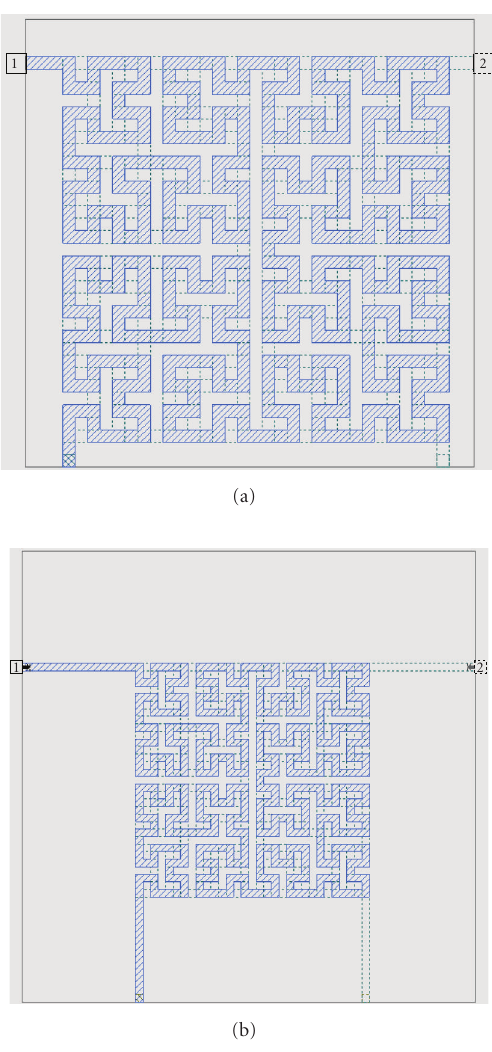
Figure 8: A top view of fractal transformers realized with two Hilbert curves N = 4, (a) w p = w s = 10 μ m, (b) w p = w s = 6 μ m.